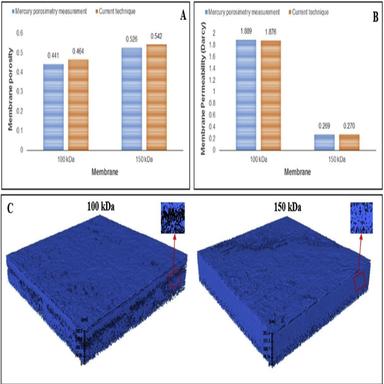
Porosity (A) and permeability (B) of virgin membranes (100 kDa and 150 kDa) by using mercury intrusion porosimetry method and our current technique; and 3-D OCT images of membrane structure (C). In these images, blue and black colors correspond to solid and free space, respectively. (For interpretation of the references to color in this figure legend, the reader is referred to the Web version of this article.)